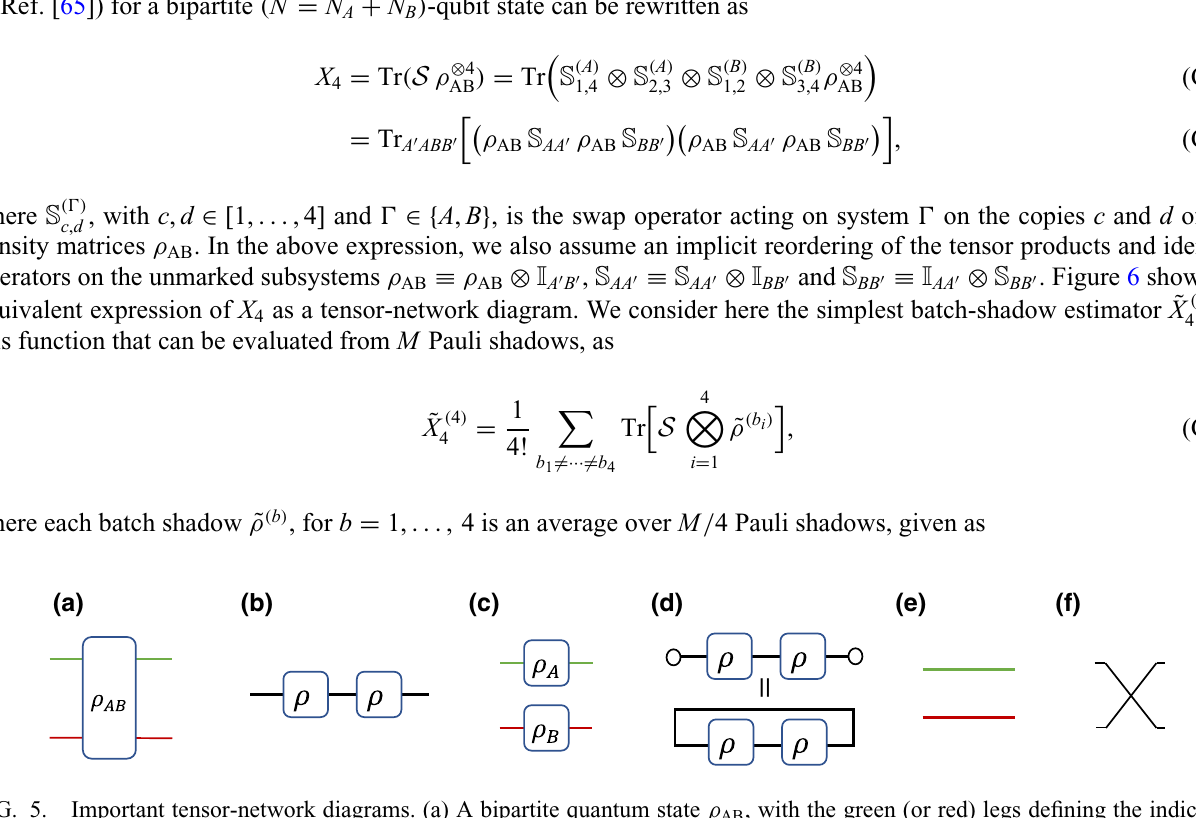
FIG. 5. Important tensor-network diagrams. (a) A bipartite quantum state ρ AB , with the green (or red) legs defining the indices of subsystem A (or B ), respectively. (b) By index contraction, we have multiplication of two matrices, giving ρ 2 . (c) ρ A ⊗ ρ B . (d) Tr (ρ 2 ) , where we replace the standard trace loop by circles at the end points that virtually connect to each other only horizontally at the same level. (e) The identity function of each subsystem, I A ⊗ I B = I AB . (f) The swap operator: S k , l ( | i k (cid:5) ⊗ | i l (cid:5) ) = | i l (cid:5) ⊗ | i k (cid:5)